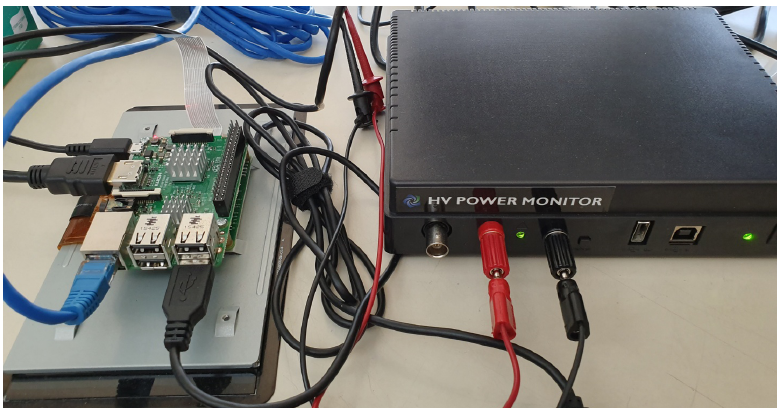
Figure 8. Experimental environment for measuring power consumption on embedded